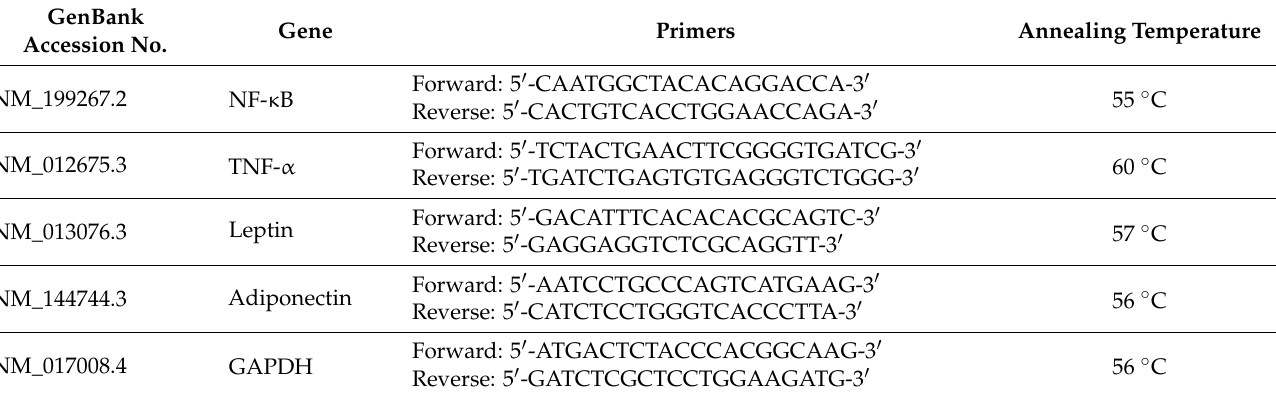
Table 1. Primers and annealing temperatures used in real-time